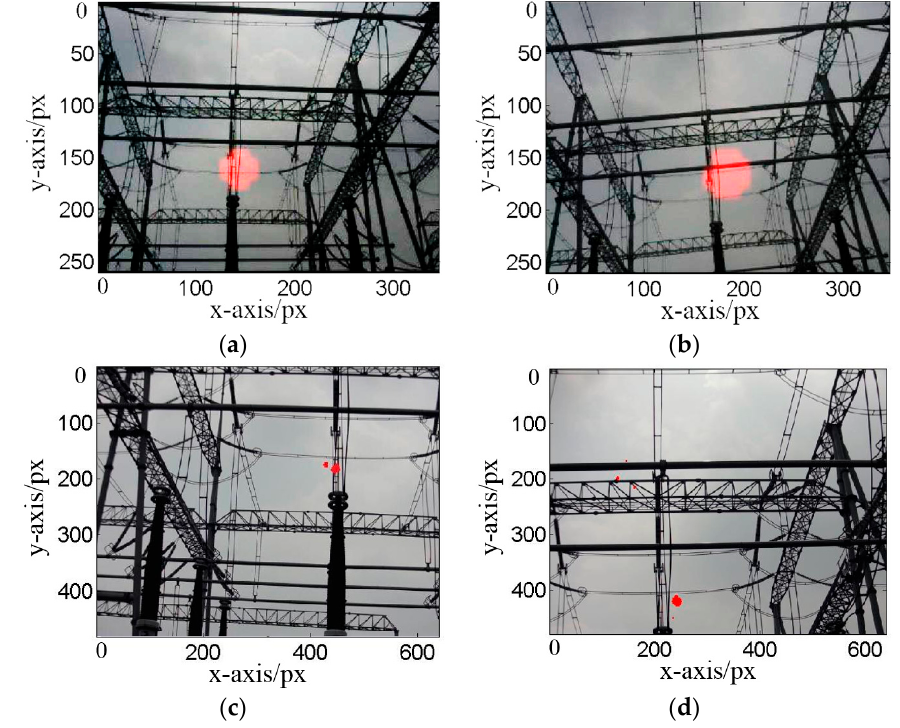
Figure 12. Detection results in an air insulated substation (AIS) with a temperature of 37 °C and humidity of 48%. ( a ) Ultrasonic results at 25 m; ( b ) Ultrasonic results at 30 m; ( c ) UV results at 25 m; ( d ) UV results at 30 m.